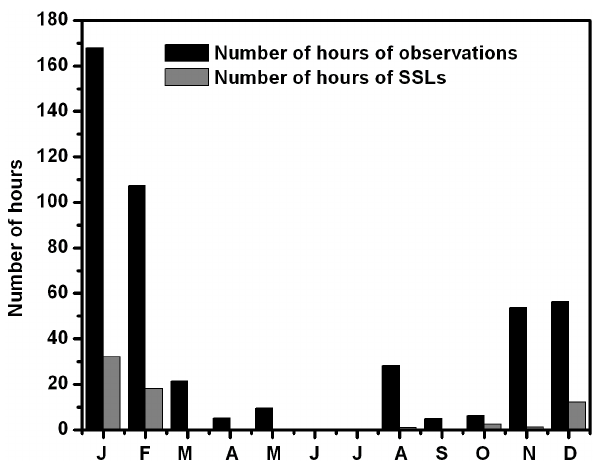
Fig. 2. Histogram of the number of hours of sodium density ob- servations (solid bar) and SSL events (grey bar) for each month of January 2005–May 2006.